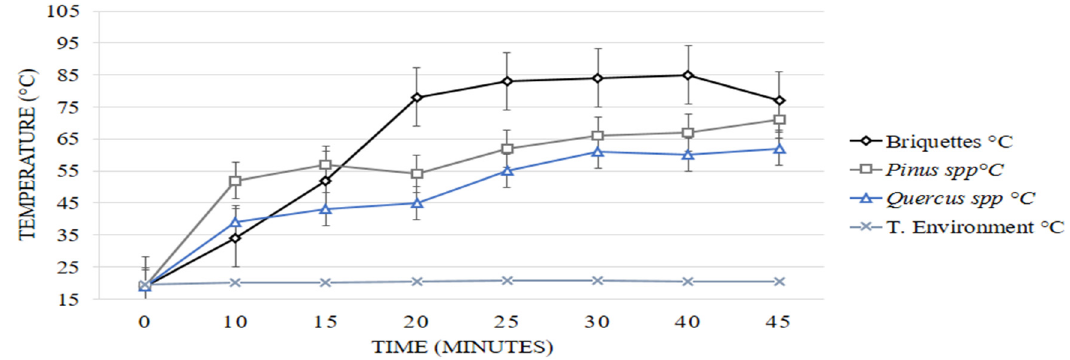
Figure 14. Temperature difference of the water heated by the three biofuels during combustion.